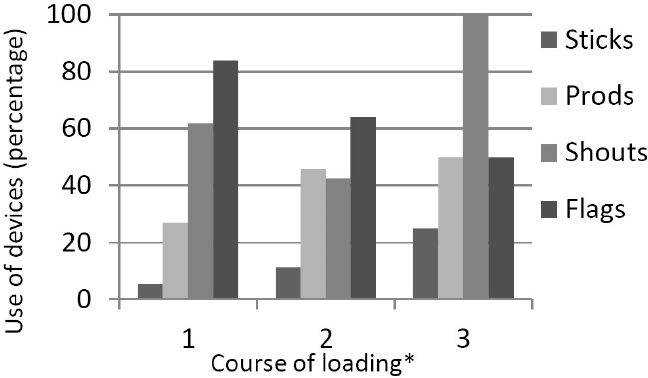
Figure 1 . The use of devices in different courses of loading as interpreted by truck driver. *: Interpretation course of loading by truck driver (1 = good, 2 = neutral, 3 = bad). Table 1 . The use of devices when loading cattle. Table 1. The use of devices when loading